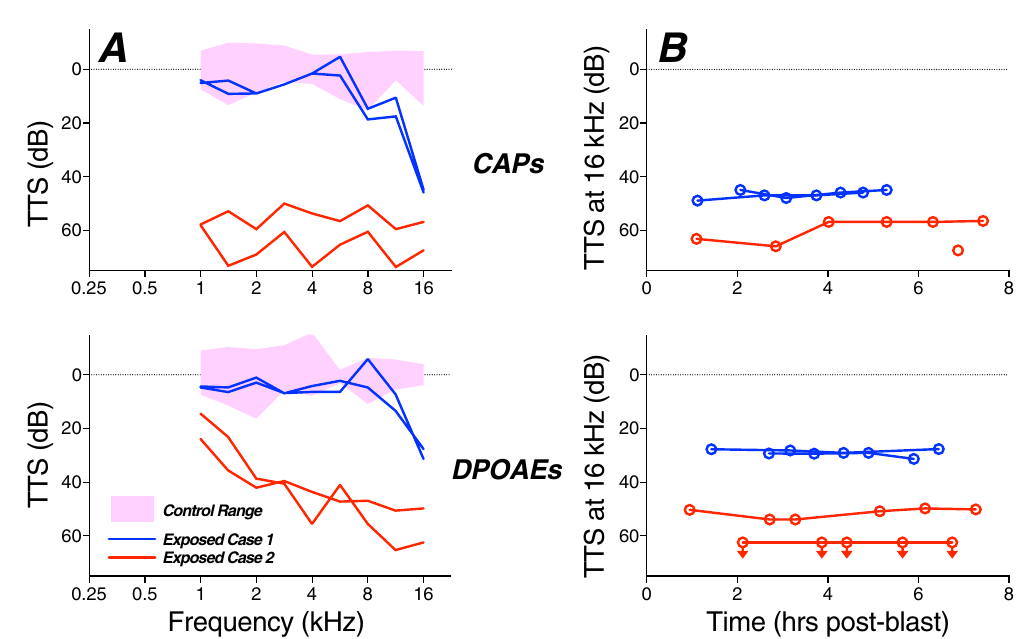
Figure 9. The amount of temporary threshold shift (TTS) was highly variable, as shown here for two ears from two animals exposed to 10 blasts @ 165 dB SPL. ( A ) Threshold shifts for CAPs and DPOAEs as measured 5.5–7.5 hrs after the blast. Control range (pink shading) is from Fig. 4B. ( B ) Threshold shifts at 16 kHz for each of the four animals at numerous post-blast time points show the stability of threshold shifts in this acute phase. Downward arrows indicate minimum estimates because thresholds were higher than those for system- generated distortion. One ear only had CAP measures at one post-blast timepoint. All data are normalized to control